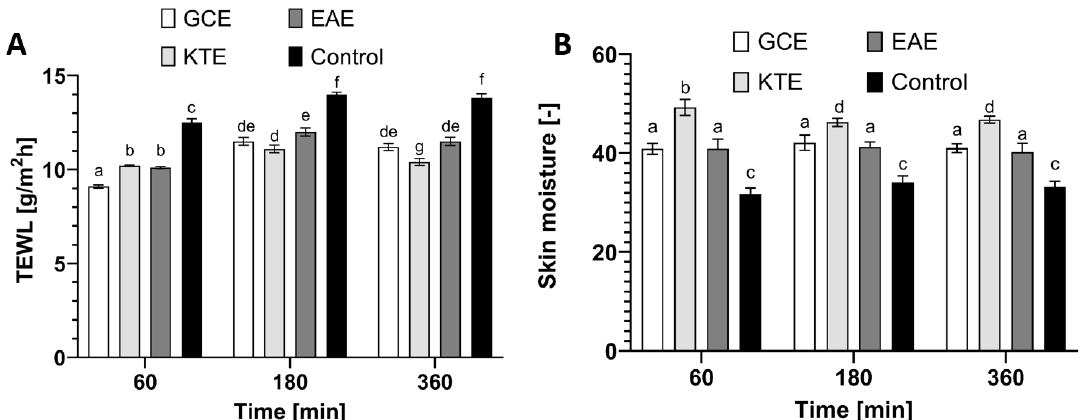
Figure 17. Influence of Centella asiatica L. (GKE), Clitoria ternatea L. (KTE) and Epilobium angustifolium L. (EAE) extracts (10 µg/mL) on transepidermal water loss (TEWL) ( A ) and skin hydration ( B ). The determinations were made in five replicates. Different letters on the charts indicate significant differences between groups ( p < 0.05).